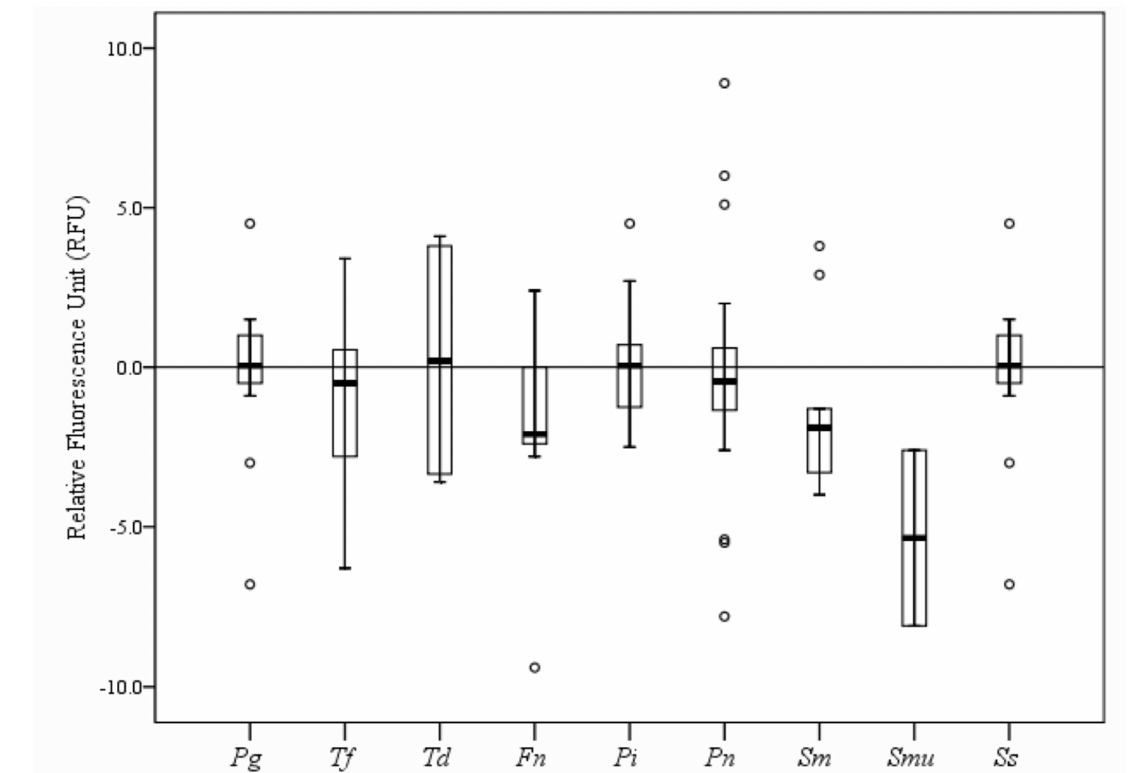
Figure 3. Quantitative changes in oral microbial species in OLP patients after 4 weeks of dexamethasone gargle. (Pg: Porphyromonas gingivalis , 10 5 RFU; Tf: Tannerella forsythia , 10 5 RFU; Td: Treponema denticola , 10 4 RFU; Fn: Fusobacterium nucleatum , 10 6 RFU; Pi: Prevotella intermedia , 10 6 RFU; Pn: Prevotella nigrescens , 10 4 RFU; Sm: Streptococcus mitis , 10 6 RFU; Smu: Streptococcus mutans , 10 5 RFU; Ss: Streptococcus sobrinus , 10 5